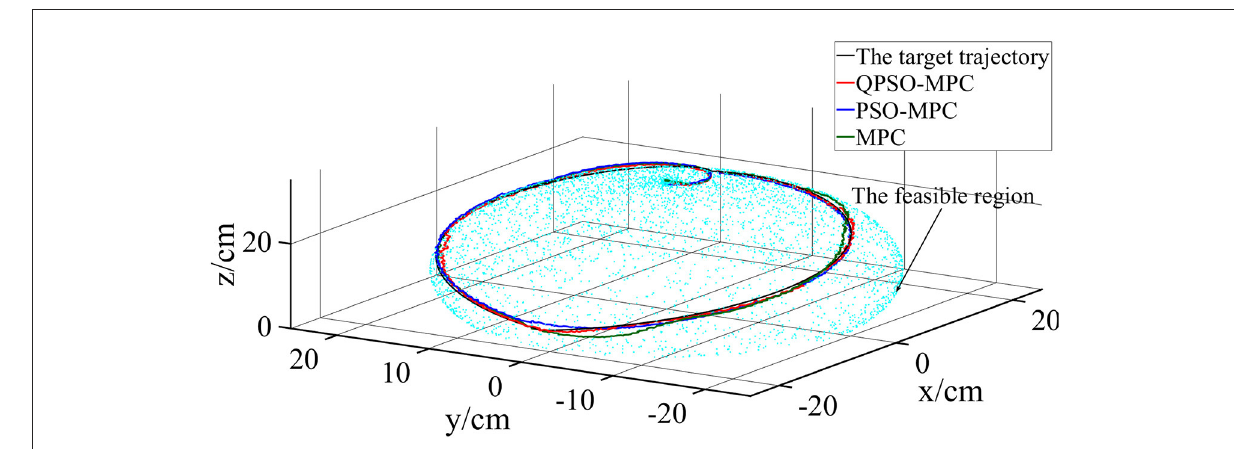
FIGURE8 Experiment results of the cardioid trajectory